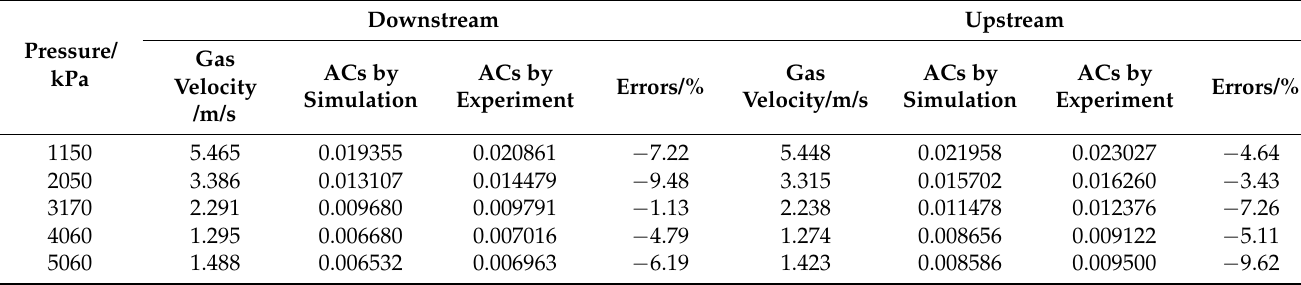
Table 7. The ACs when acoustic waves propagate downstream and